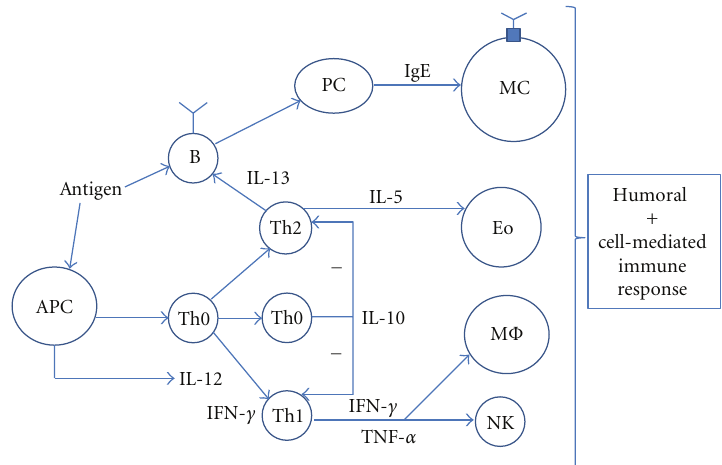
Figure 1: Seasonal allergic rhinitis related immunological subsystems, pathways, and